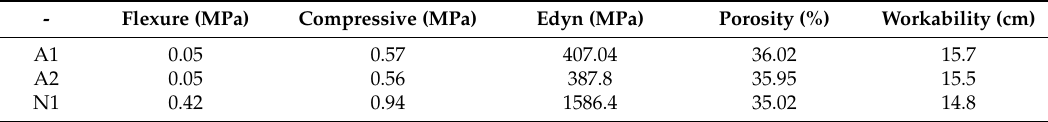
Table 3. Mechanical and physical properties of mortars at the age of 28